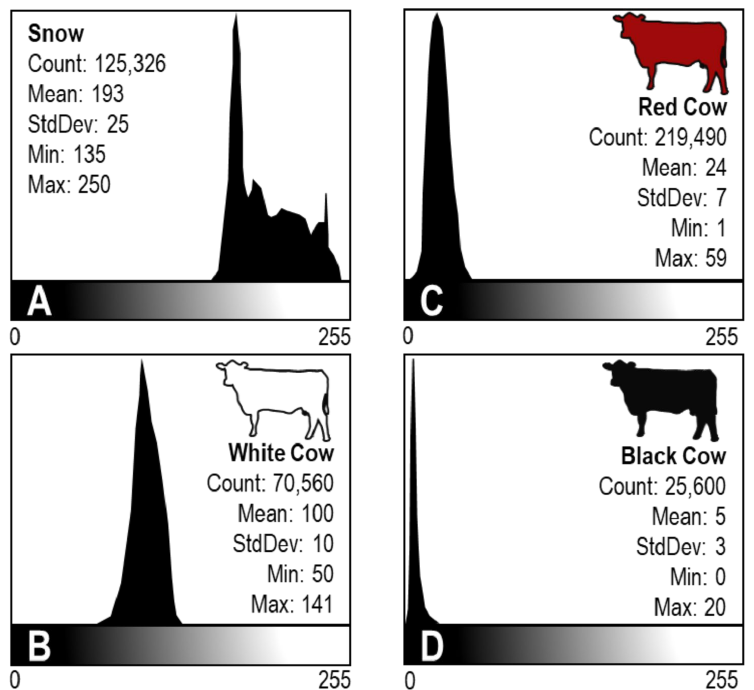
Figure 1. Example of image analysis histograms of frequency of occurrences of different gray pixel values as an indicator of brightness. Each histogram represents pixels selected for ( A ) snow, ( B ) a white cow, ( C ) a red cow, and ( D ) a black cow, concurrently in a photo. Photos were taken in January 2016 west of Laramie, WY, USA at the University of Wyoming, Agricultural Experiment Station, Laramie Research and Extension Center—Beef Unit and cattle were Bos taurus cows. Analyses were conducted using open-source image analysis software ImageJ. In each image, snow pixels in the image were analyzed as the reference and consid- ered the baseline constant using a typical snow albedo value of 0.85 [19,20]. For each image, I developed a histogram of the frequency of occurrences of different gray values of selected snow and different colored cow pixels (Figure 1). The mean of these gray value occurrences is an indicator of the brightness of selected pixels which is possible because digital images are produced by a combination of red, green, and blue primary color pixels and each color has a brightness value ranging from 0 to 255 (Figure 1). I used three different images as replicates and then calculated the mean albedo value for snow, and white, red, and black cows within each image [21,22]. For each cow color, I first cal-